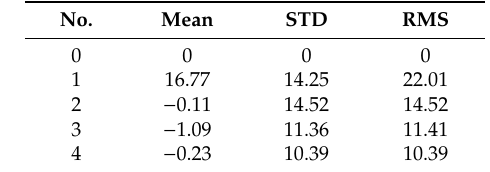
Note. The units are Eötvös. STD = standard deviation; RMS = root mean